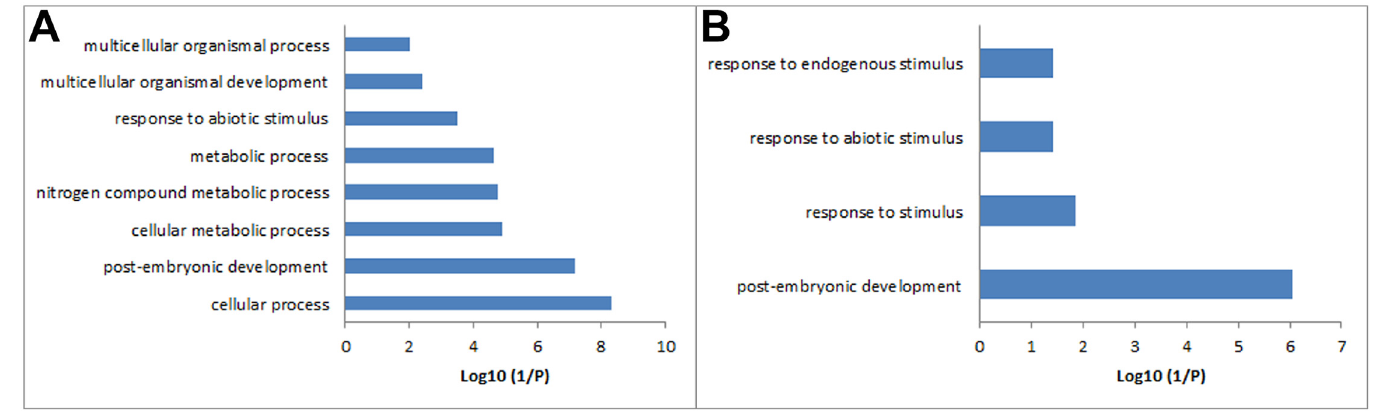
Fig 6. GO biological process annotation of the species-specific conserved genes. (A) Annotation of the 1912 R . soongorica conserved genes; (B) annotation of the 723 sand rice conserved genes.